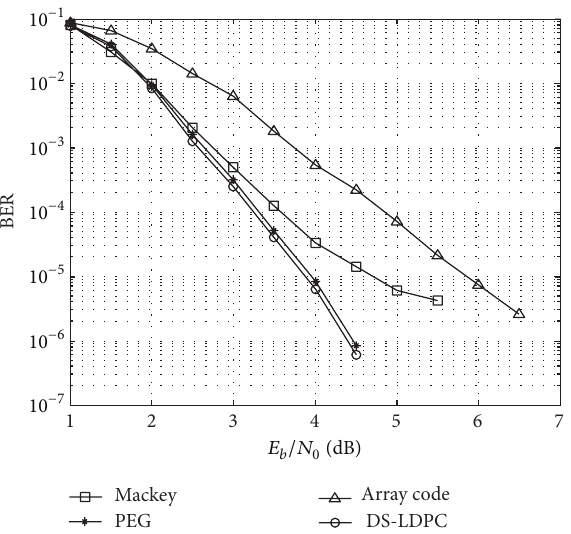
Figure 3: The BER curve comparison between QC-LDPC con- structed by differential sequences, Mackay, PEG algorithm, and array codes.